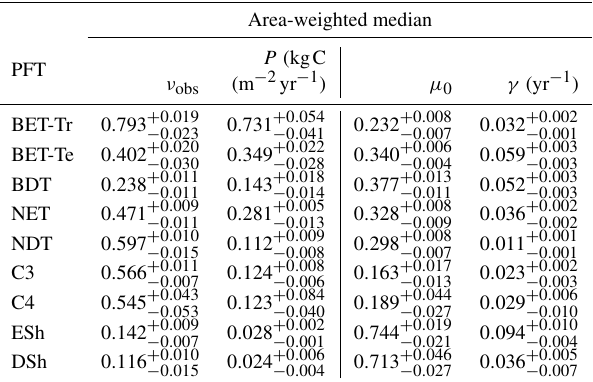
Table 5. The area-weighted median values of observed coverage and driving net assimilate against µ 0 and γ for the upper quartile of grid boxes for each